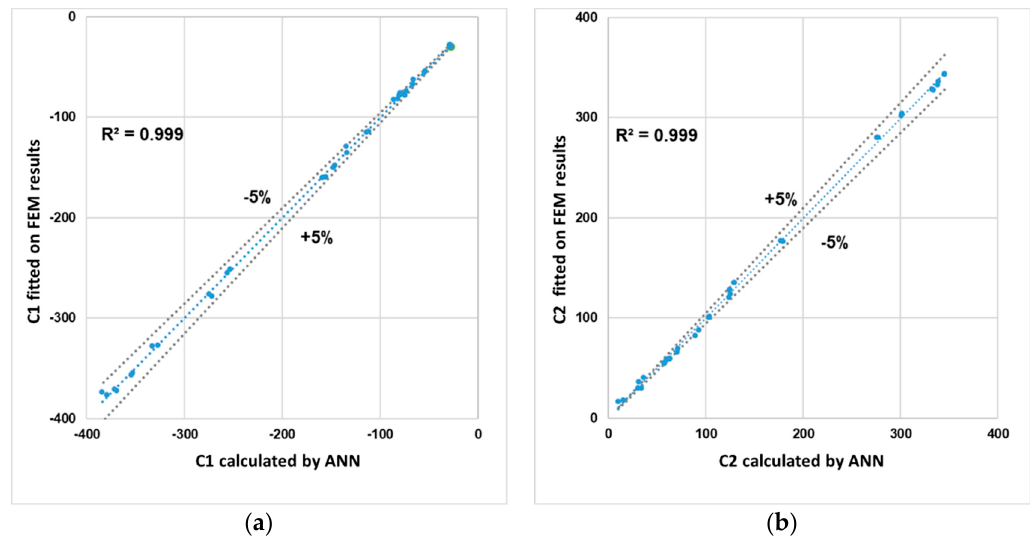
Figure 6. Plot of C1 from the analytical model C1 (target) versus the ANN trained C1 in blue with error bands at +5% and − 5% in grey ( a ) and the analytical model C2 (target) versus the ANN trained C2 in blue with error bands at +5% and − 5% in grey ( b ).